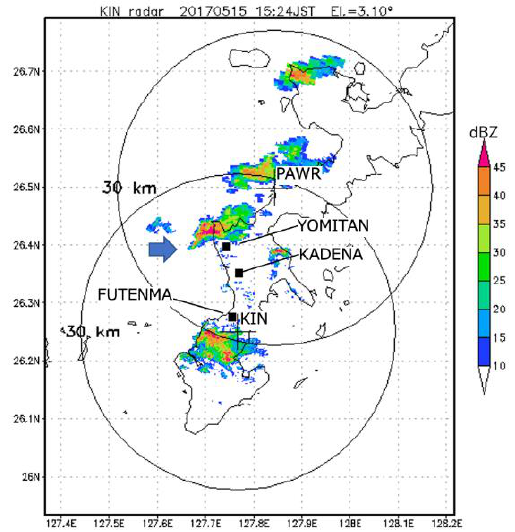
Figure 1. Locations of KIN radar and PAWR (+) with their 30 km observation range. Radar echo pattern (in dBZ) from KIN radar (elevation angle = 3.1 ◦ ) at 15:24 JST (Japan Standard Time) on 15 May 2017. The target precipitation system is indicated by an arrow. The locations of Kadena Air Base, Marine Corps Air Station Futenma, and Yomitan village are indicated by